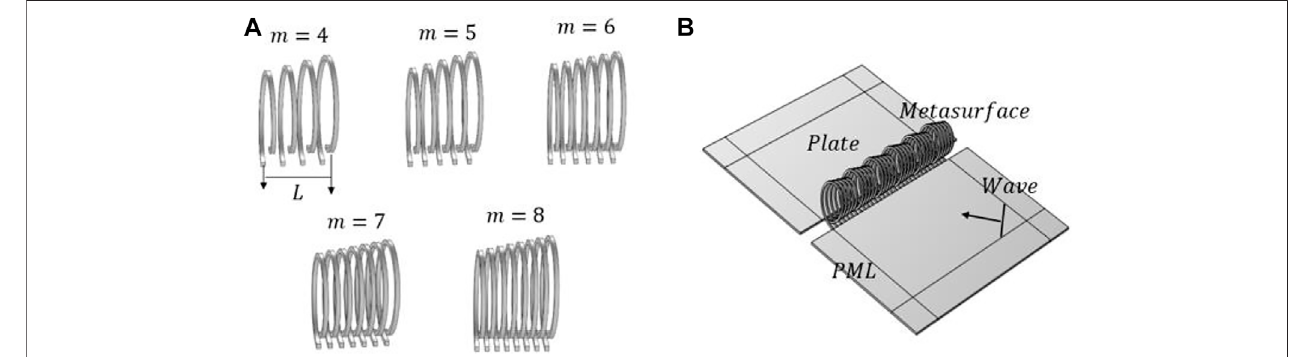
FIGURE 4 | (A) Helical metasurface structures with different numbers of unit cells; (B) Schematic diagram of the overall structure.